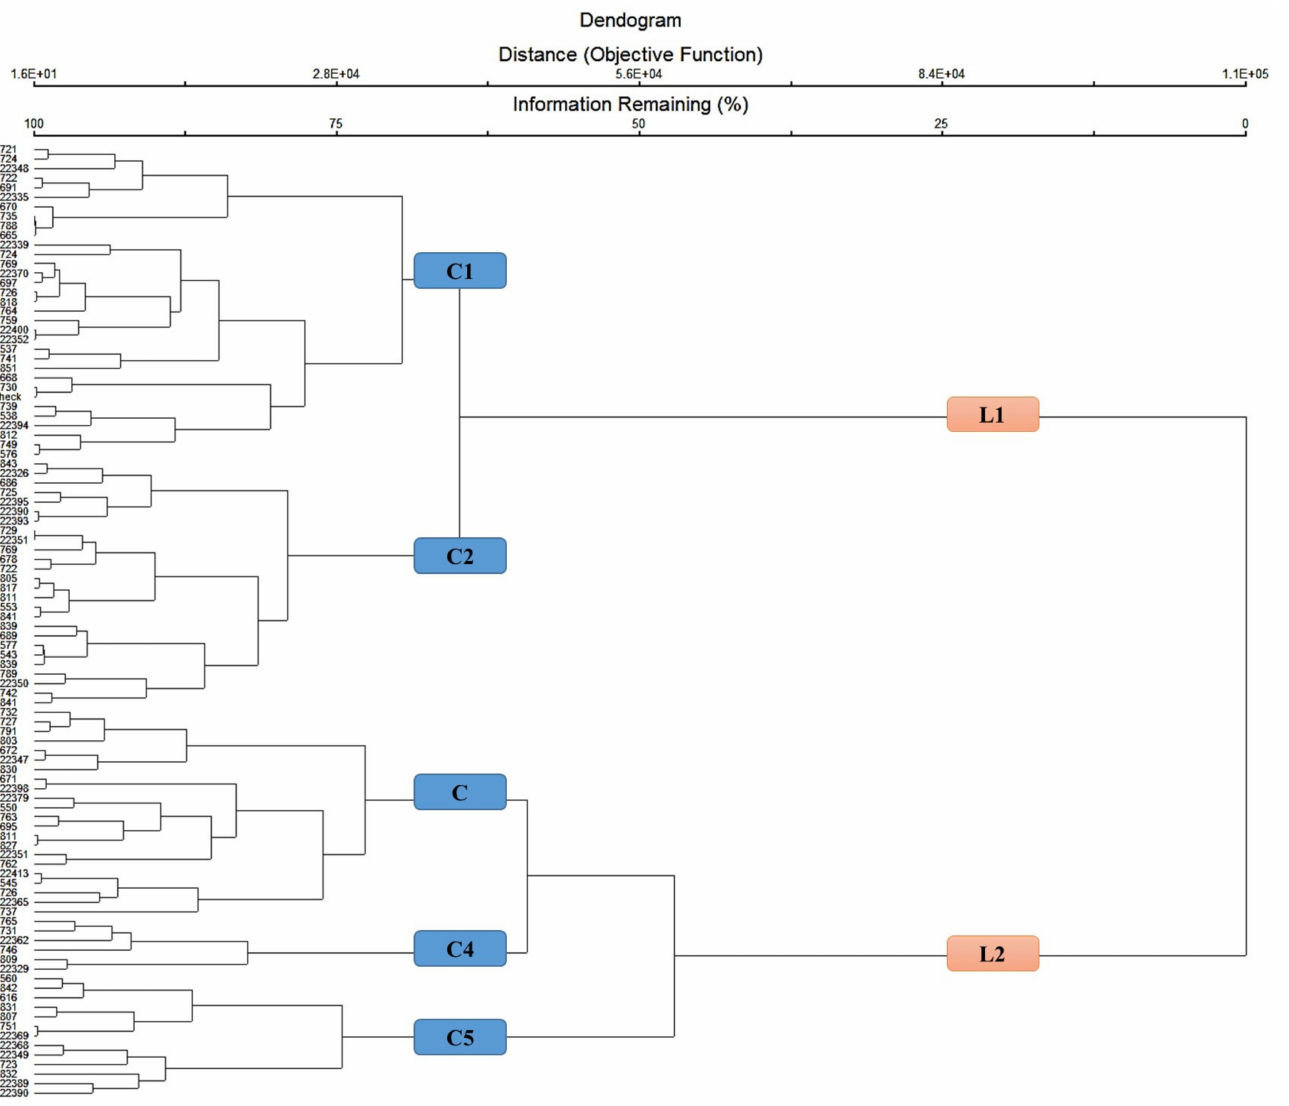
Figure 4. Cluster dendrogram of 100 genotypes of Oat ( Avena sativa ) based on 14 quantitative traits during 2020. The mean performance of all traits were calculated for both the years where cluster 6 was found to have the lowest DF and DM value (2019) while in (2020) while the lowest DM were recorded in cluster 4. The high grain yield genotypes were from cluster 1 (2019) with a mean value of 38.2 ± 0.2 g, followed by cluster 3 genotypes with a mean value of 22.16 ± 5.71, whereas in 2020, the highest grain yield was found in cluster 2, which may be selected in future breeding practices of the oat plant. In cluster 2, the highest BM mean value = 122.5 ± 9.55 was recorded (Tables 4 and